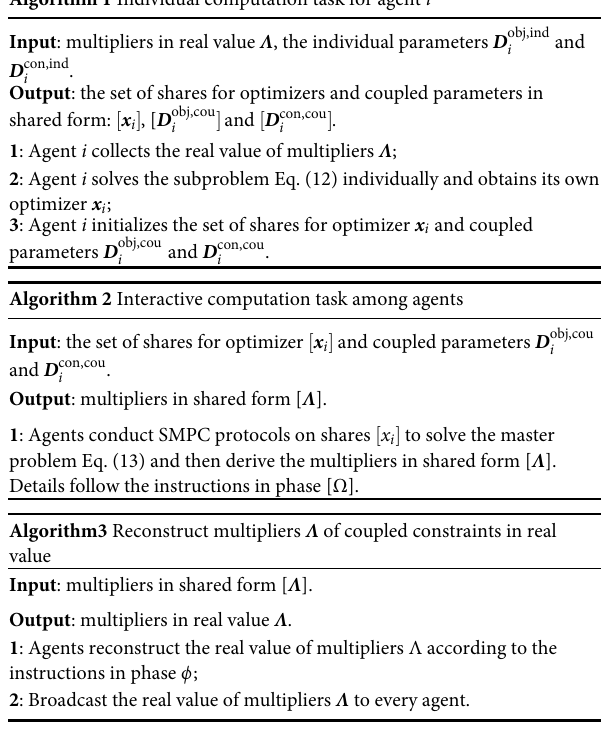
Fig. 6 The convergence process of the improved SMPC framework based on the D&C method. Algorithm 1 Individual computation task for agent i